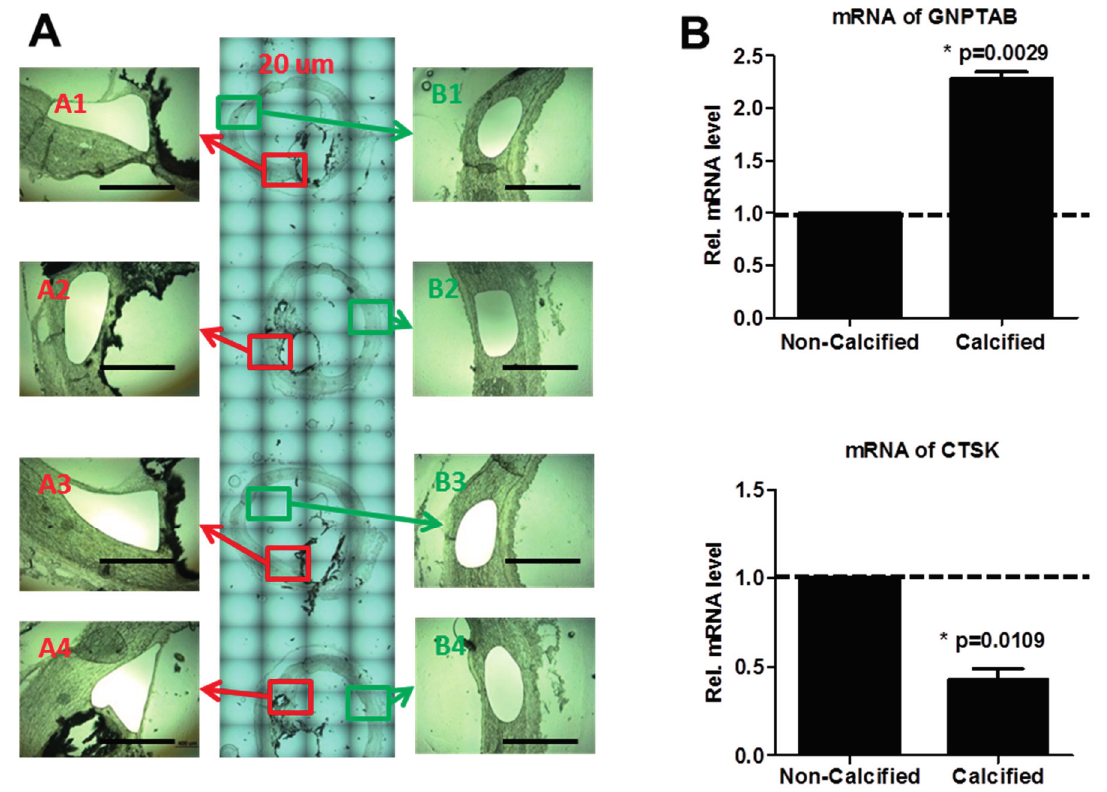
Figure 2. ( A ) Laser-capture microdissection-assisted mRNA analysis in human calcified carotid arteries. Four adjacent 20-µm sections both from GNPTAB-positive calcified areas (A1–A4) and GNPTAB-negative non-calcified areas (B1–B4) were pooled for RNA extraction. Bars = 500 µm; ( B ) mRNA levels of GNPTAB and CTSK in GNPTAB-positive calcified areas versus GNPTAB-negative non-calcified areas. ( n = 4; two technical replicates